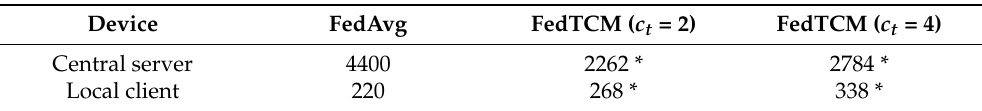
Table 4. Number of model parameters sent/received by different methods, * denotes the result of